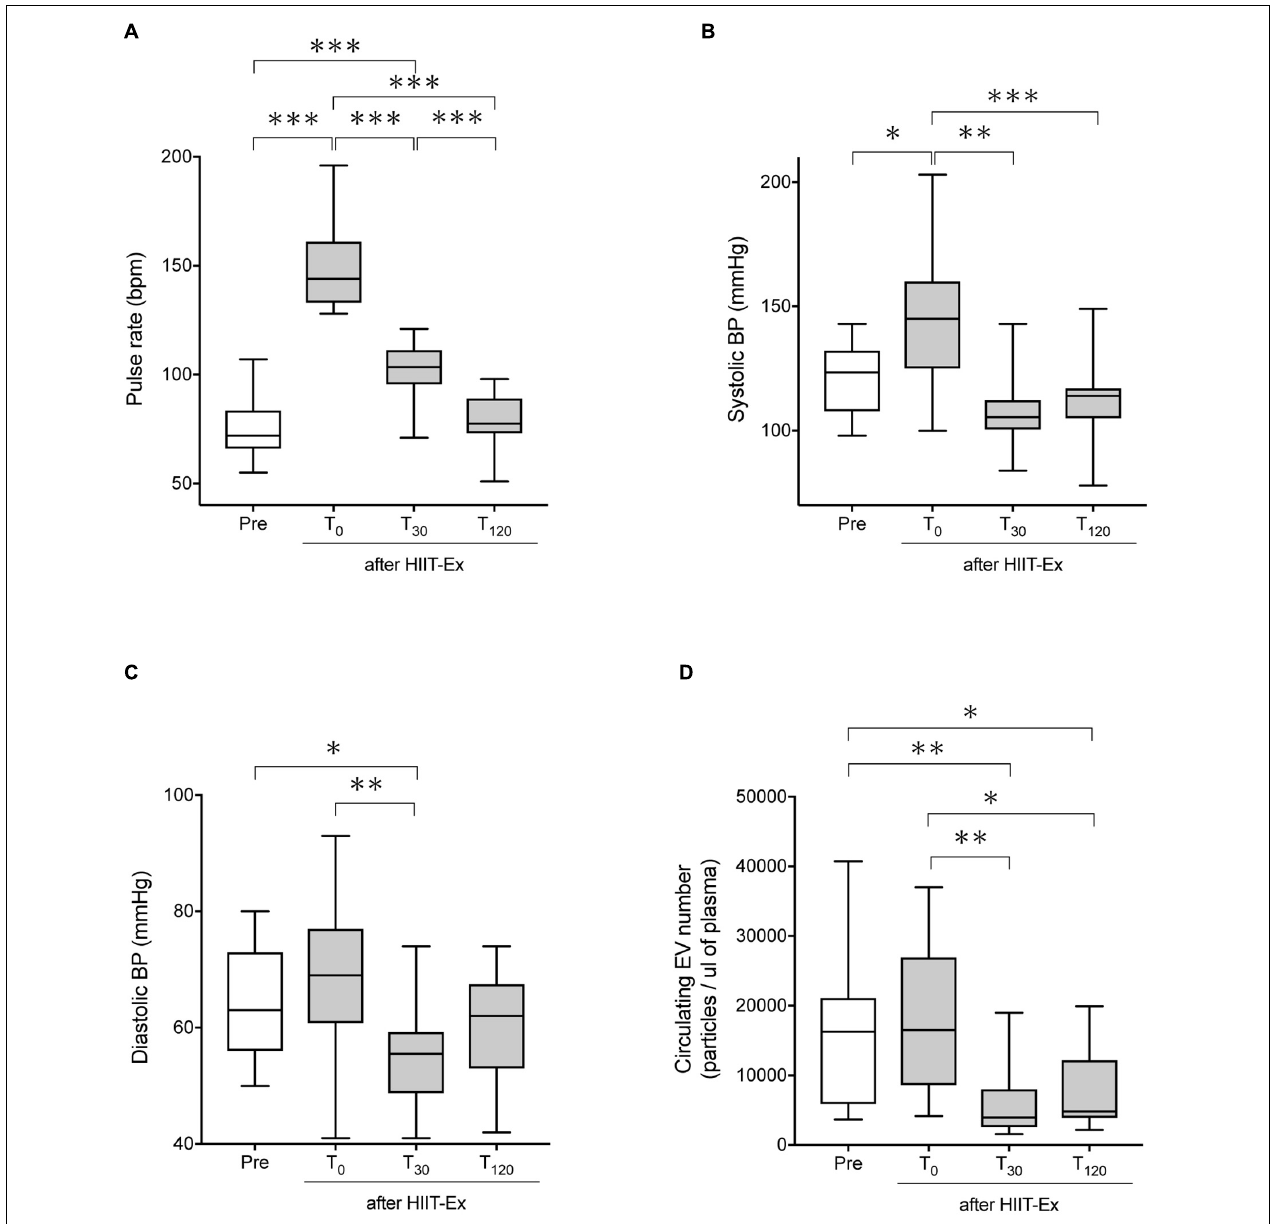
FIGURE 2 | The pulse rate, systolic BP, diastolic BP, and circulating EV number before and after HIIT-Ex. Changes in pulse rate (A) , systolic blood pressure (B) , diastolic blood pressure (C) , and circulating EV number (D) in HIIT-Ex in all participants. Kruskal–Wallis test was used for statistical analysis. ∗∗∗ p < 0.001. ∗∗ p < 0.01, ∗ p < 0.05. BP, blood pressure; bpm, beats per minute. Pre: pre-HIIT-Ex.